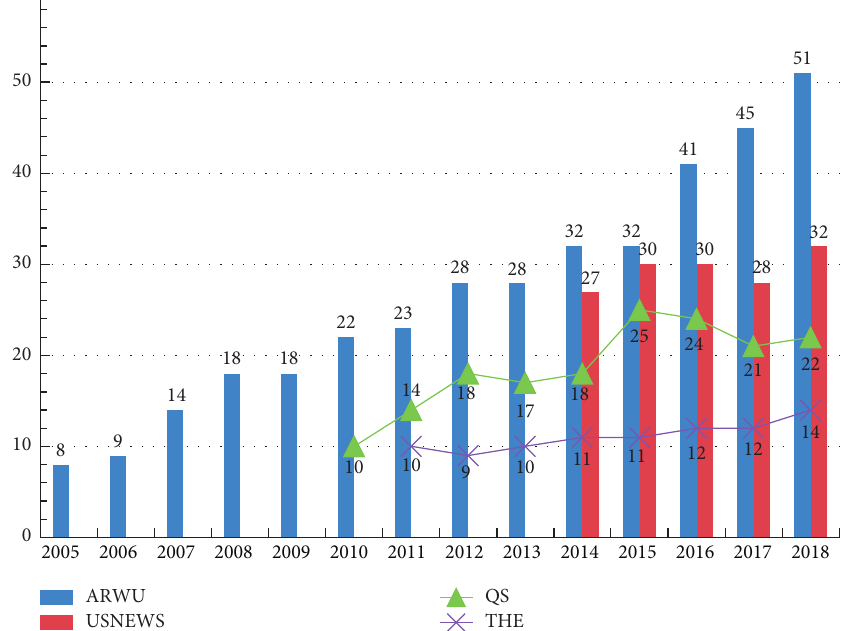
Figure 1: Number of Chinese mainland universities listed in the four major